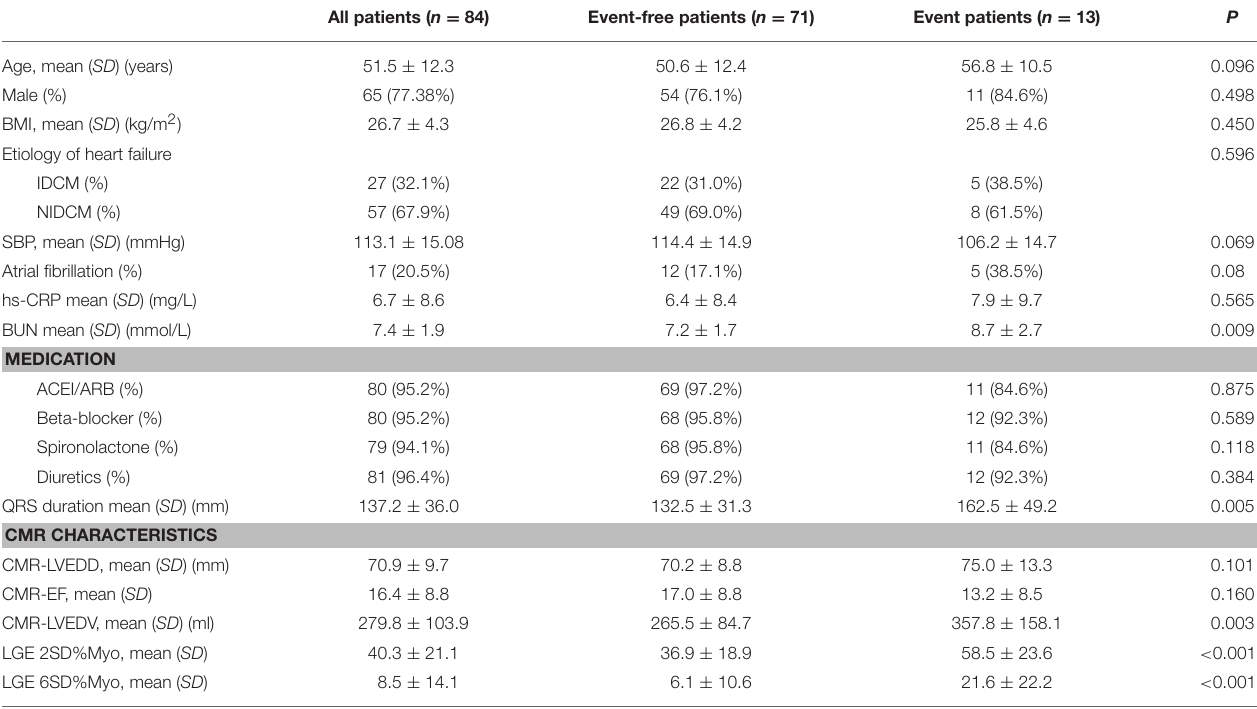
TABLE 1 | Baseline characteristics of patients with stage C&D heart failure. All patients ( n =